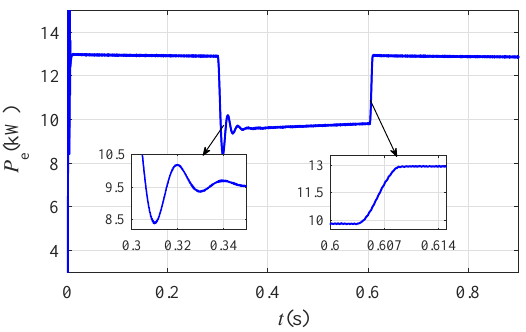
Figure 9. Variation of active power under backstepping control strategy.